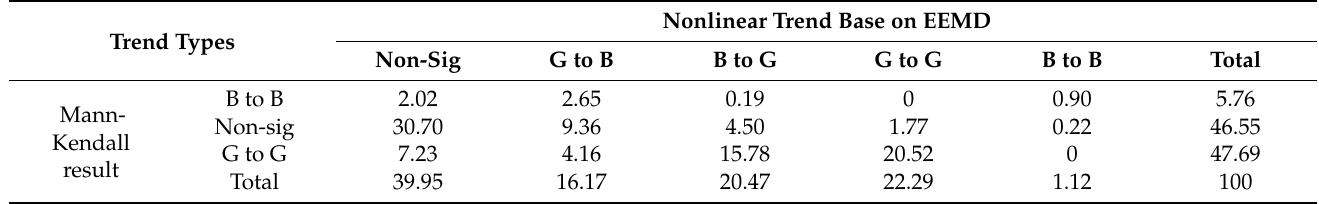
Table 3. Superposition statistics of linear and nonlinear trend type results